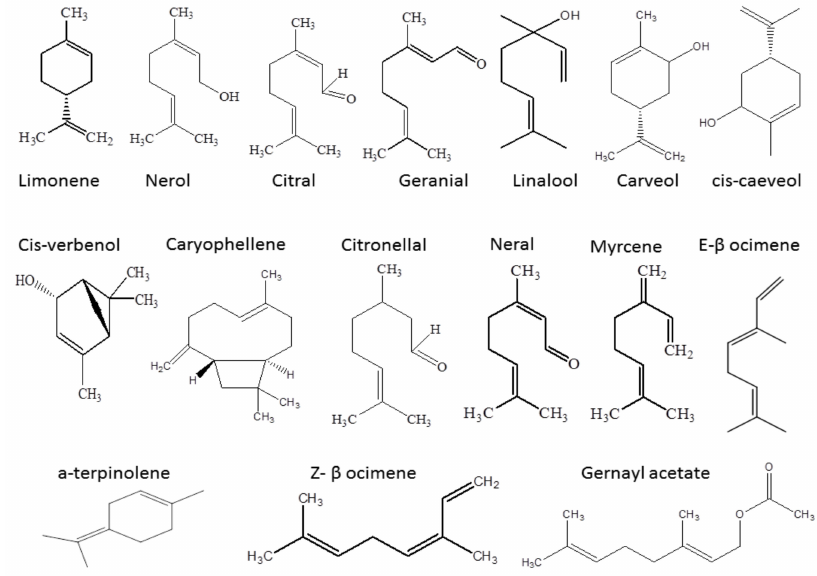
Figure 1. Bioactive components extracted from